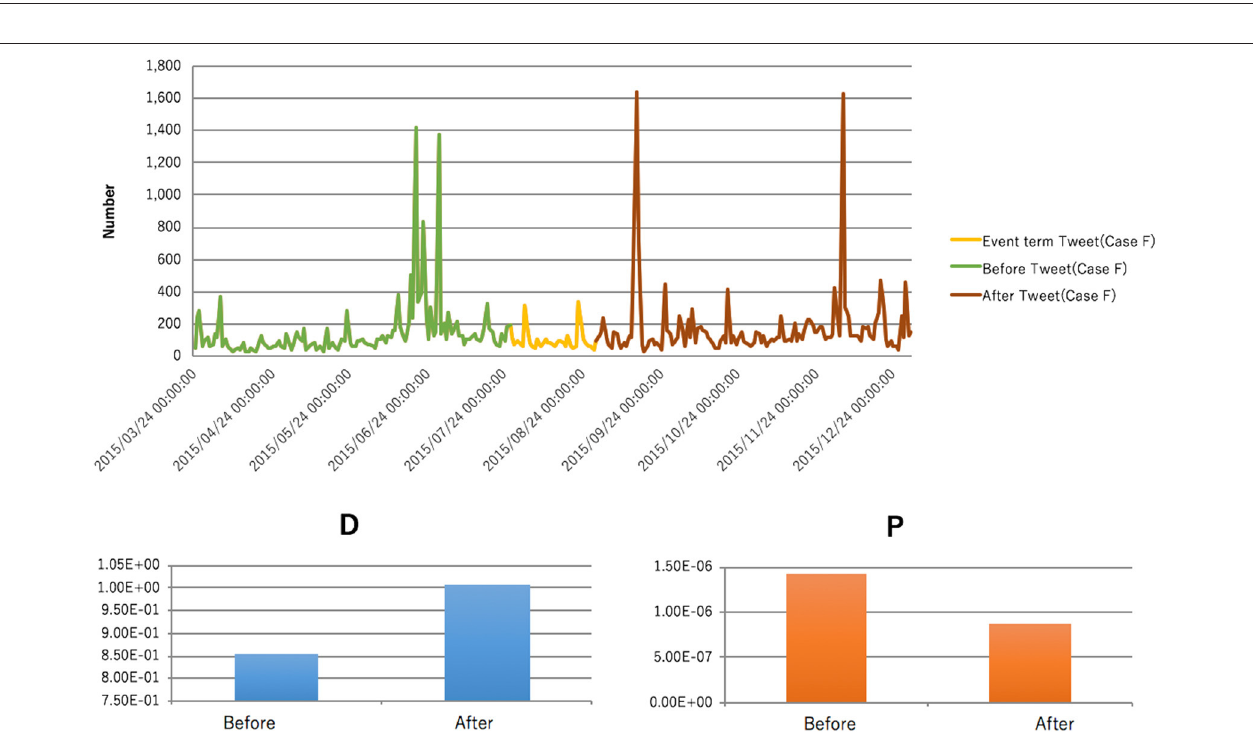
FIGURE 6 | Analysis of the “Case F,” before and after event in Japan, in the summer of 2016.